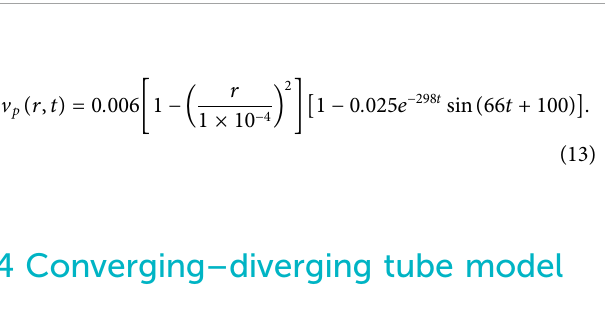
Figure 5A. Two diverging-shaped tubes and one converging- shaped tube are connected with each other. Each tube has a maximum radius of 100 μ m and a minimum radius of 50 μ m, as well as a tube length of 250 μ m. Fifty particles were injected at the same velocity with the initial fl uid velocity from the inlet boundary to the outlet boundary. The details of the simulation are same as those of the straight-tube model except that the